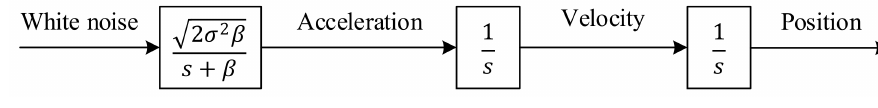
Figure 2. Gauss–Markov model